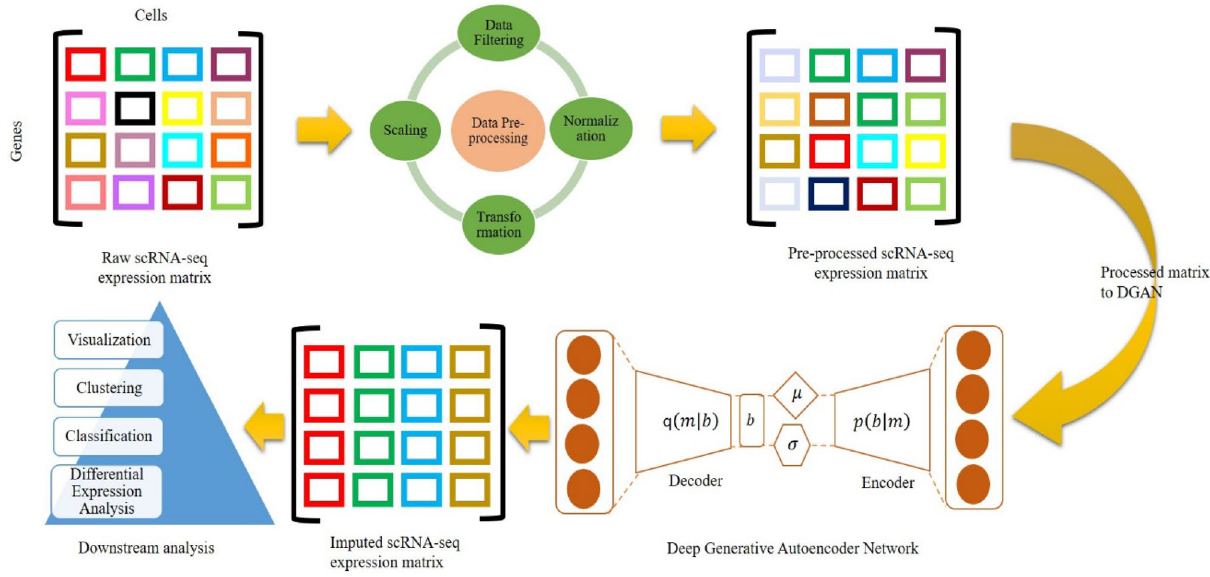
Figure 1. Schematic of deep generative autoencoder network (DGAN) downstream functional analysis pipeline for scRNA-seq data: The real input matrix ‘m’ is filtered for bad genes, normalize them according to library size and pruned by log transformed and scaling. The processed matrix is then fed into the DGAN model, which learns gene expression data depiction and reconstructs the imputed matrix. Finally, these imputed matrix facilitate extensive downstream